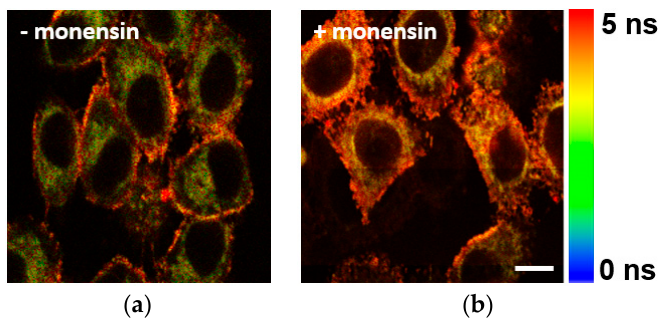
Figure 6. Fluorescence lifetime images of BTV -treated (1 µM) HeLa cells ( a ) Before and ( b ) After incubation with 10 µM monensin for 30 min. Scale bare represents 20 µm.